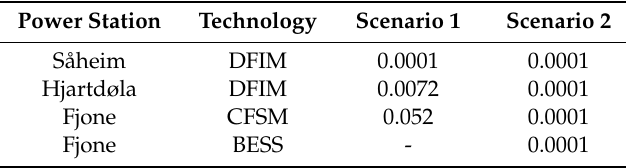
Table 9. Optimal droop coe ffi cients ( K d, α , K d, β and K d, γ ) of Scenario 1 and Scenario 2 in the year